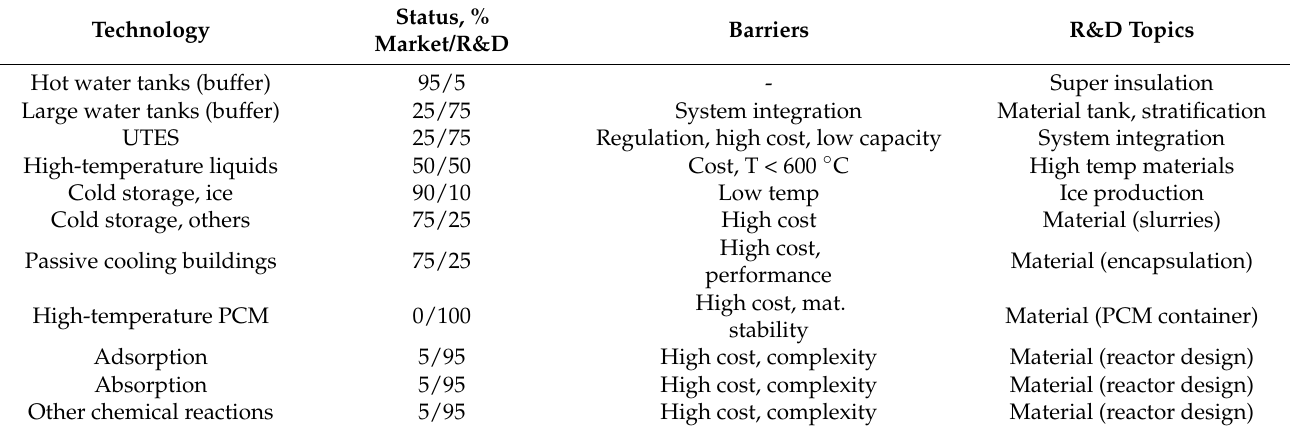
Table 12. Status, barriers, and R&D topics for